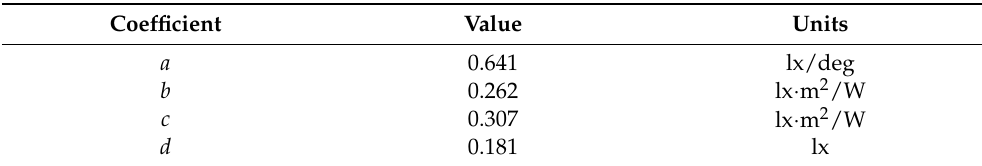
Table 1. Values of the constants of the regression model for the average lighting levels inside the classroom with heliostatic